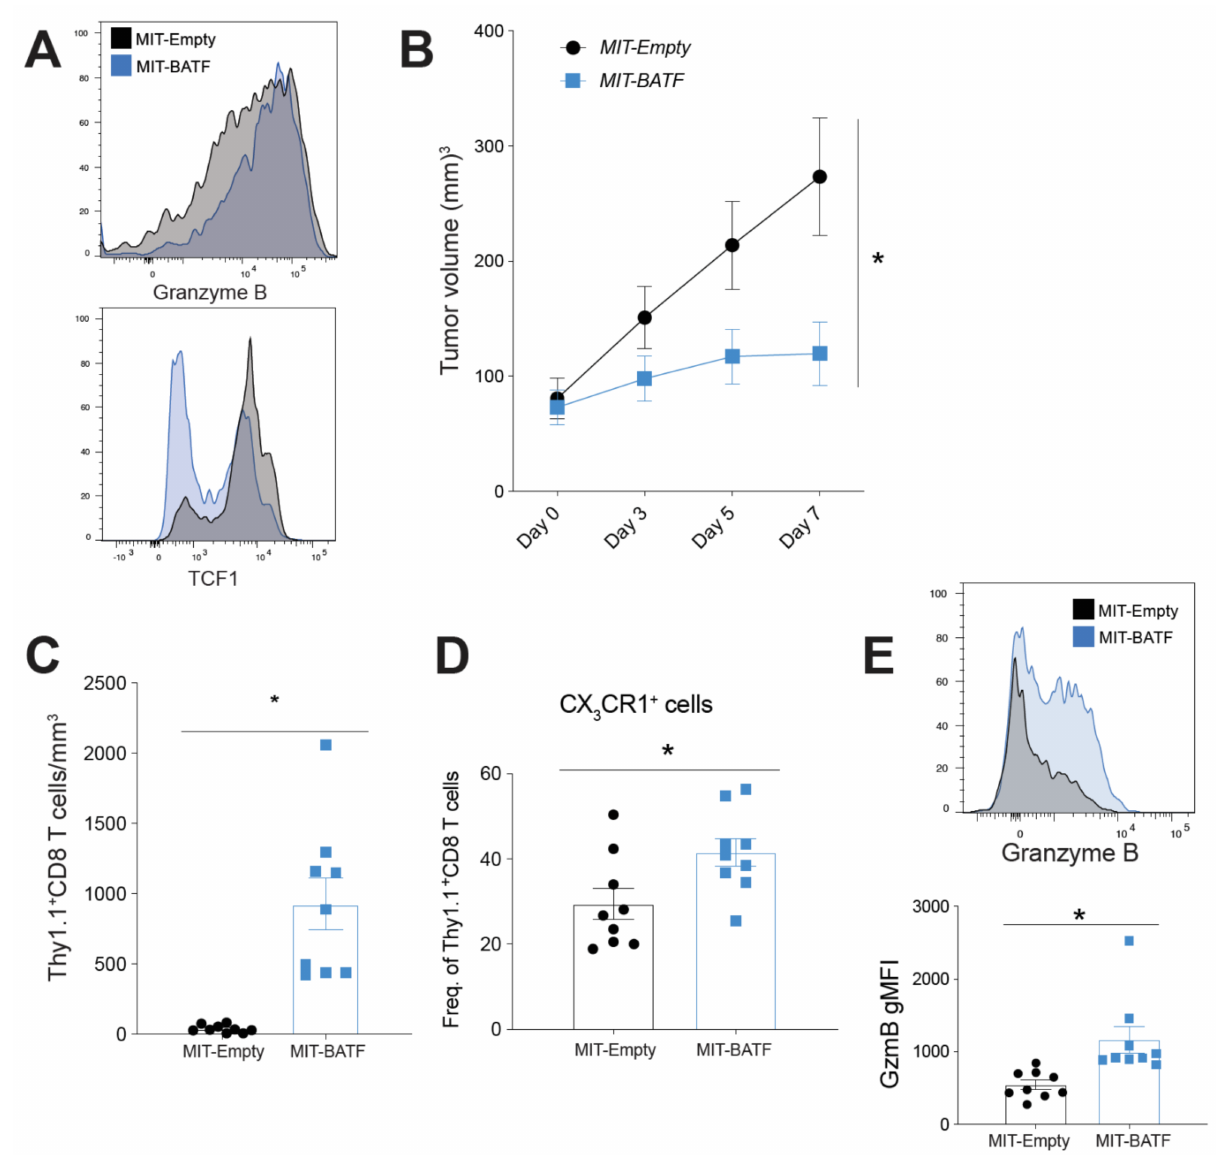
Figure 3. Adoptive transfer of BATF-overexpressing tumor-specific CD8 + T cells bypasses the need for CD4 + T cell help. Pmel CD8 + T cells were activated and transduced with either MIT-Empty- or MIT-BATF-expressing retrovirus. B16-GP33 tumor-bearing CD45.1 mice were then adoptively transferred with MIT-Empty- or MIT-BATF-transduced (Thy1.1 + ), tumor- specific CD8 + T cells. ( A ) Granzyme B and TCF1 expression levels of transduced CD8 + T cells. ( B ) Tumor volumes were measured following treatment, until sacrifice ( n = 13 mice per group). ( C ) The number of CD8 + T cells/mm 3 of tumor, assessed via cell counts and flow cytometry. ( D ) Frequency of CX 3 CR1 + population within tumor-infiltrating, adoptively transferred transduced CD8 + T cells. ( E ) Granzyme B MFI of tumor-infiltrating, adoptively transferred transduced CD8 + T cells. ( C – E , n = 9 mice per group). (* p -value <